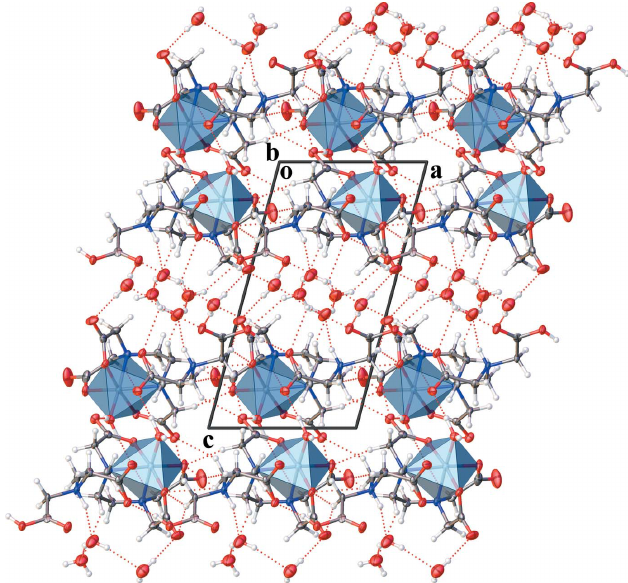
Figure 1 OLEX 2 generated depiction of the title compound, with displacement ellipsoids drawn at the 75% probability level. Dashed lines show O— H (cid:2)(cid:2)(cid:2) O and N—H (cid:2)(cid:2)(cid:2) O hydrogen bonds.